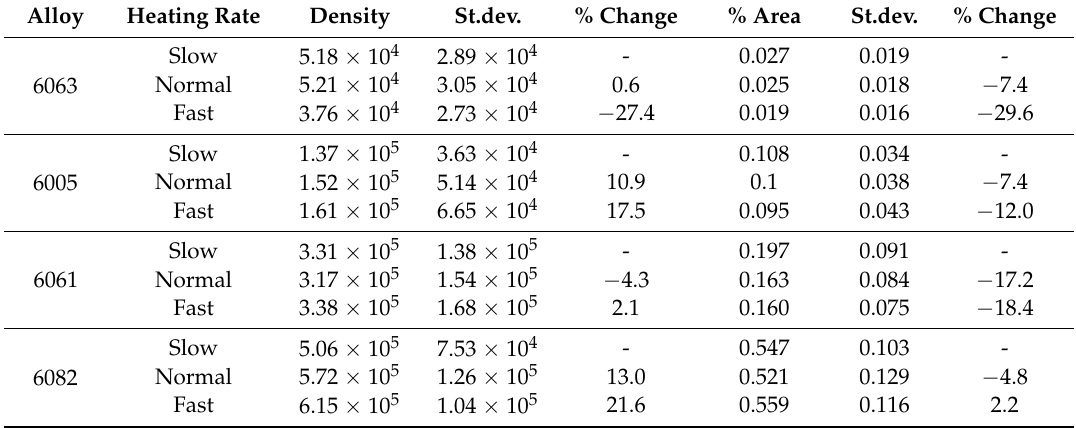
Table 2. Important results from image processing. The unit of density is #/mm 2 , and the standard deviation (St.dev.) is the variation between the images.